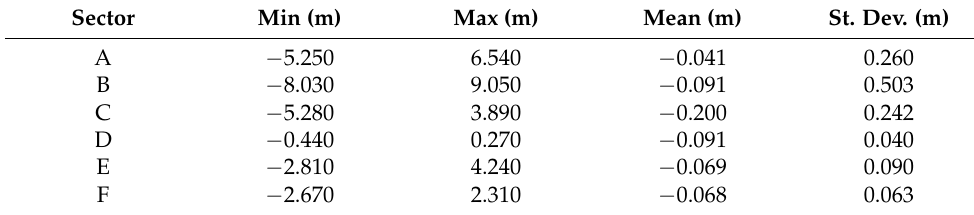
Table 7. Statistical terms of the differences of MBD values along x direction. Sector